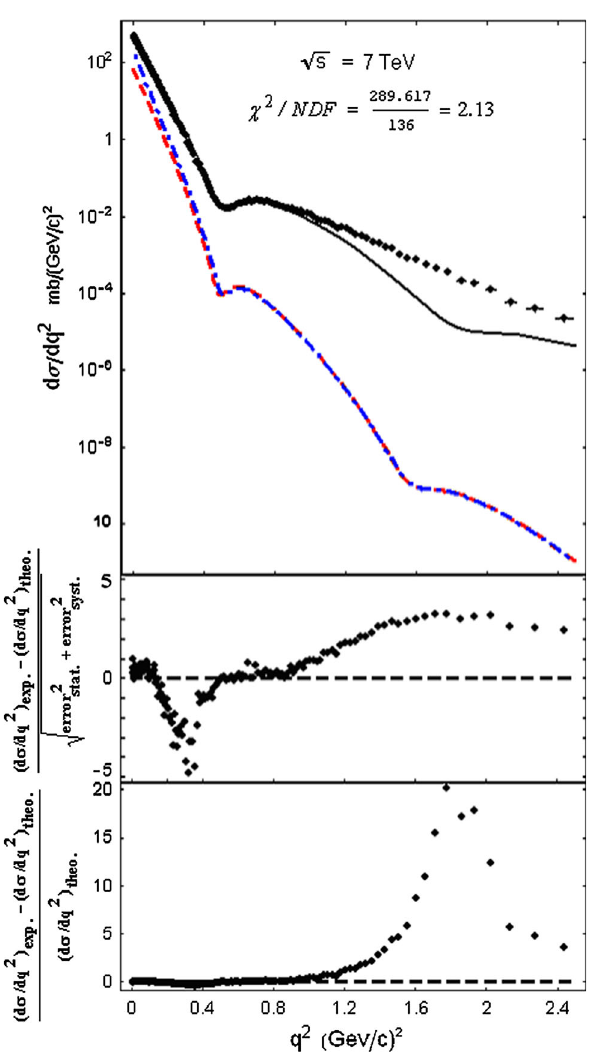
Fig. 1 Thep–pelasticscatteringdifferentialcrosssectionat7TeV.The dashed, dot-dashed and solid curves represent the results of (two-quark force) only, (two-quark force + pion cloud effect), and (two-+three- quark force+ pion-cloud effect), respectively. The experimental data are taken from